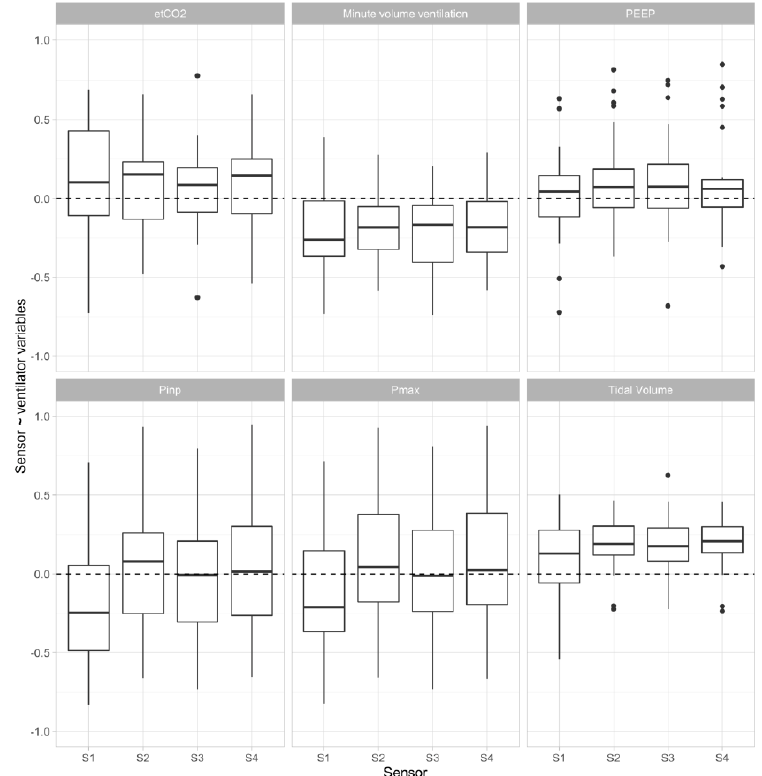
Figure 6. Mean correlation coefficient R between sensors and ventilator variables. Upper and lower “hinges” correspond to first and third quartile, respectively, and whiskers indicate 95% confidence interval.